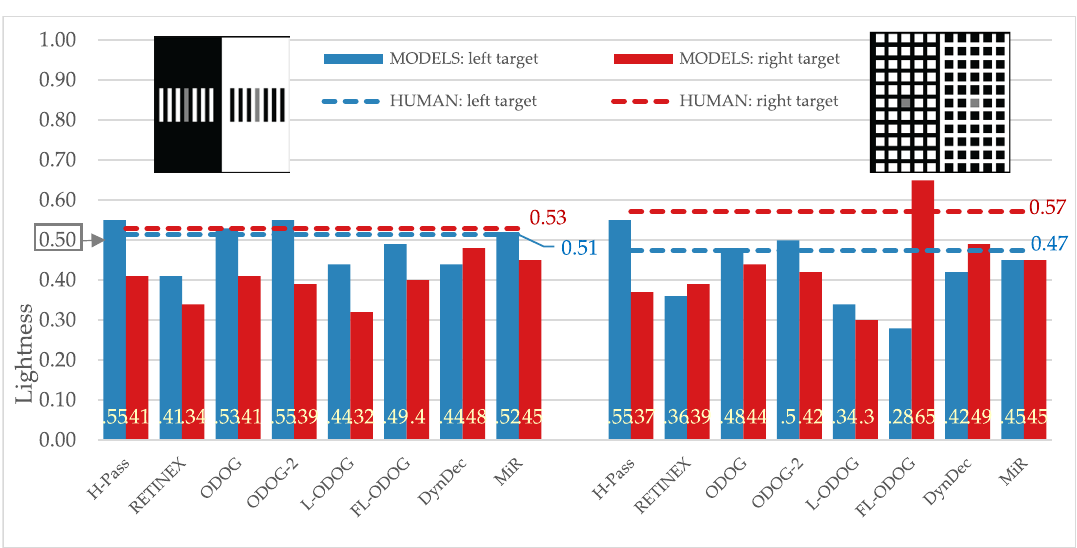
Figure 9. Empirical and model results for Reversed contrast and Dungeon illusions. The target lightness value is marked at 0.5 on the Y